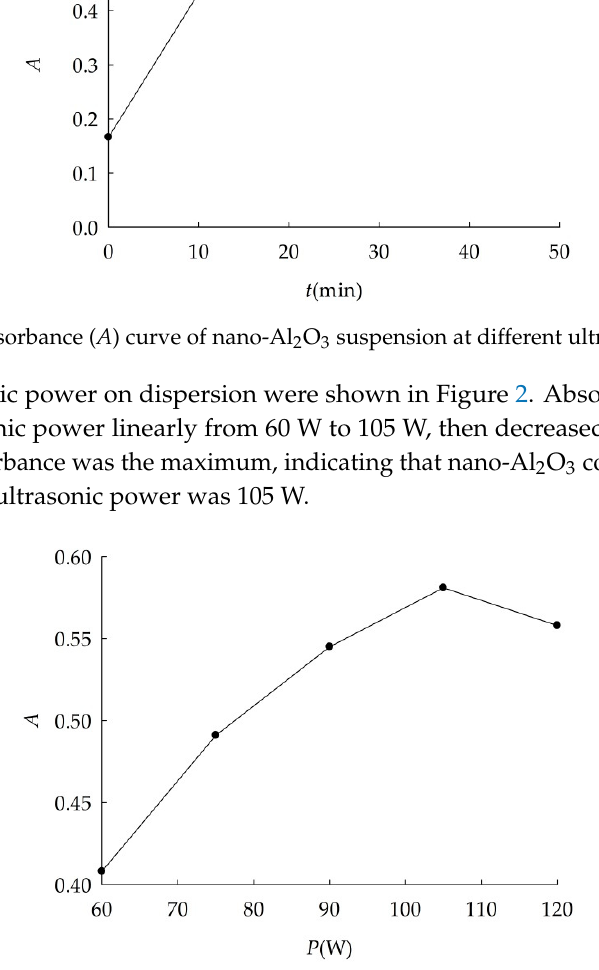
Figure 2. Absorbance ( A ) curve of nano-Al 2 O 3 suspension at different ultrasonic power.